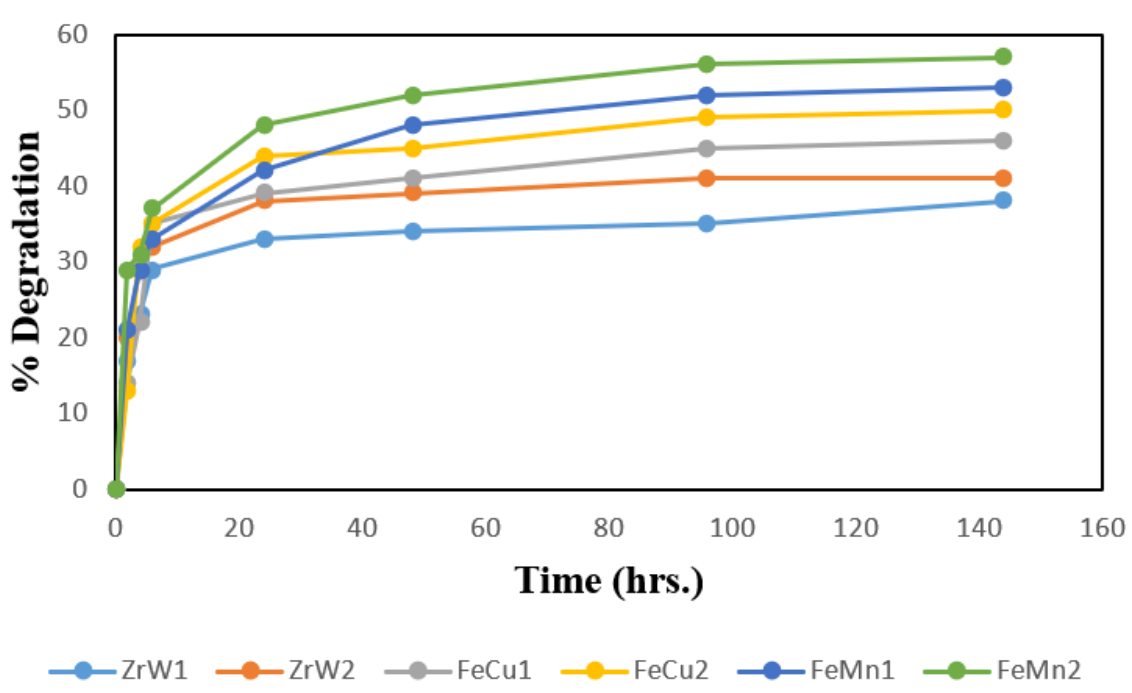
Figure 6. Contact time effect ranging from 2 h to 6 days at pH 6 for M 2 Zr 2 O 7 systems in OMW under the light.